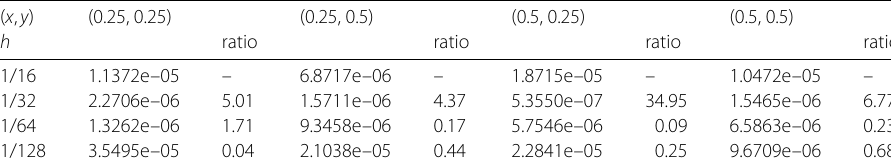
Table 4 The errors for the RBF collocation method in the sense of pointwise ( x , y